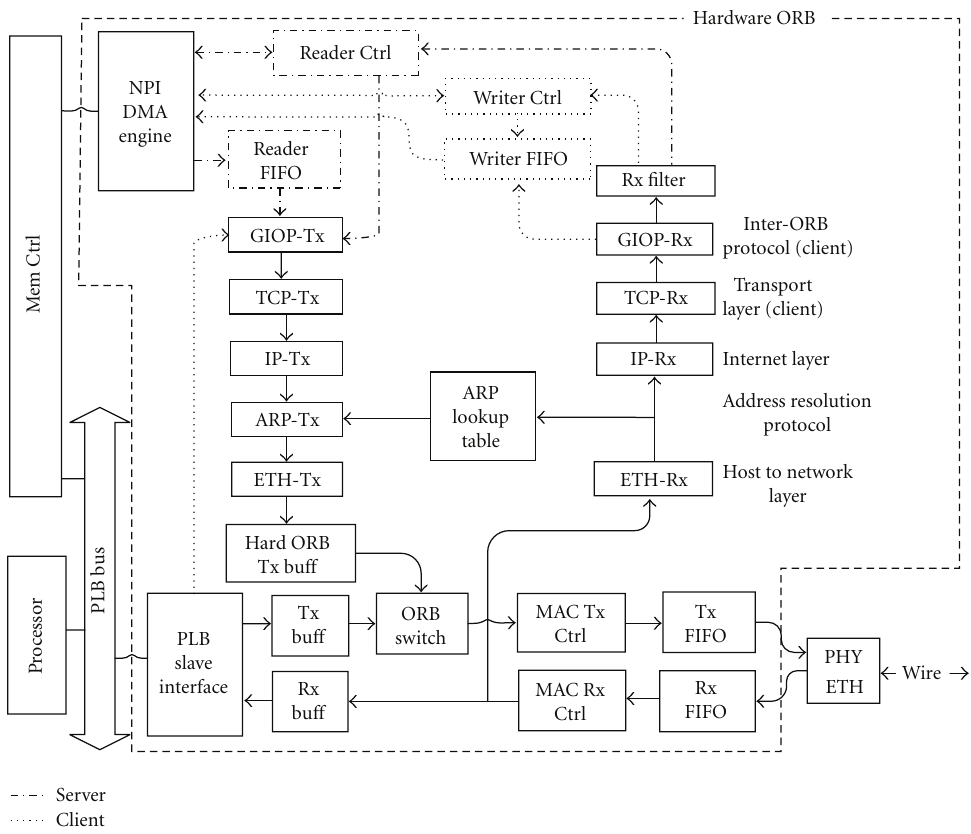
Figure 8: The architecture of the hardware ORB client/server IP core.